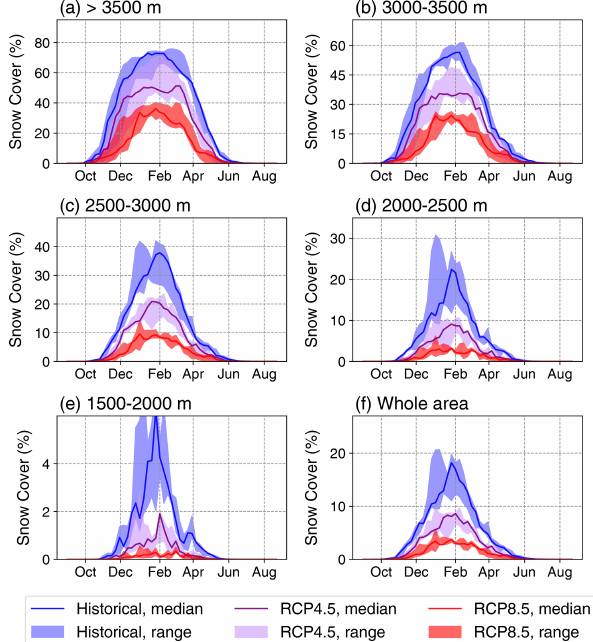
Figure 9. Annual cycles of snow cover (in %) in the three GCM- driven experiments under the historical (blue, 1976–2005), RCP4.5 (purple, 2071–2100) and RCP8.5 (red, 2071–2100) scenarios, at various elevations ranges within our study area: (a) > 3500m, (b) 3000–3500m, (c) 2500–3000m, (d) 2000–2500m, (e) 1500– 2000m and (f) whole area. Solid lines represent the three-model medians, and the shading corresponds to the three-model spreads.